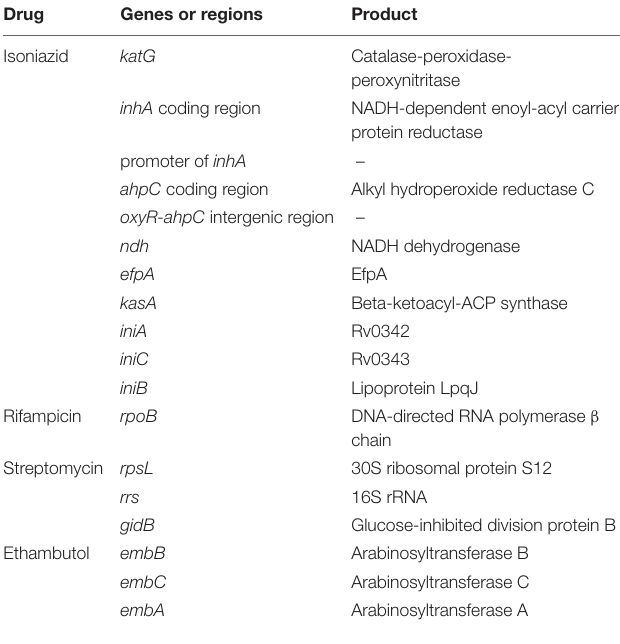
TABLE 1 | Eighteen candidate genes and intergenic regions linked with acquisition of drug